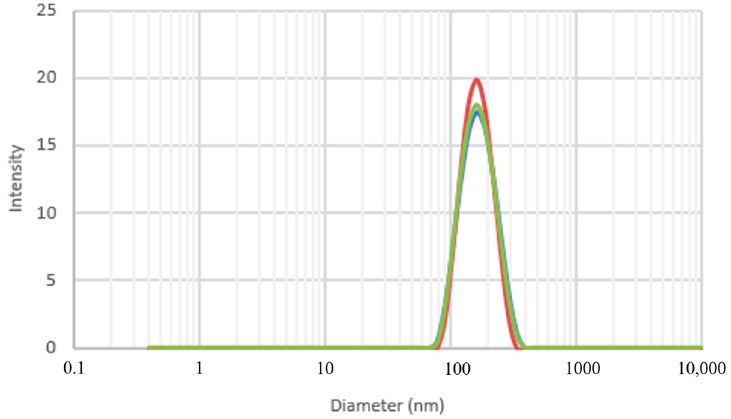
Figure 5. DLS analysis of the filtrated solution of surfactant.